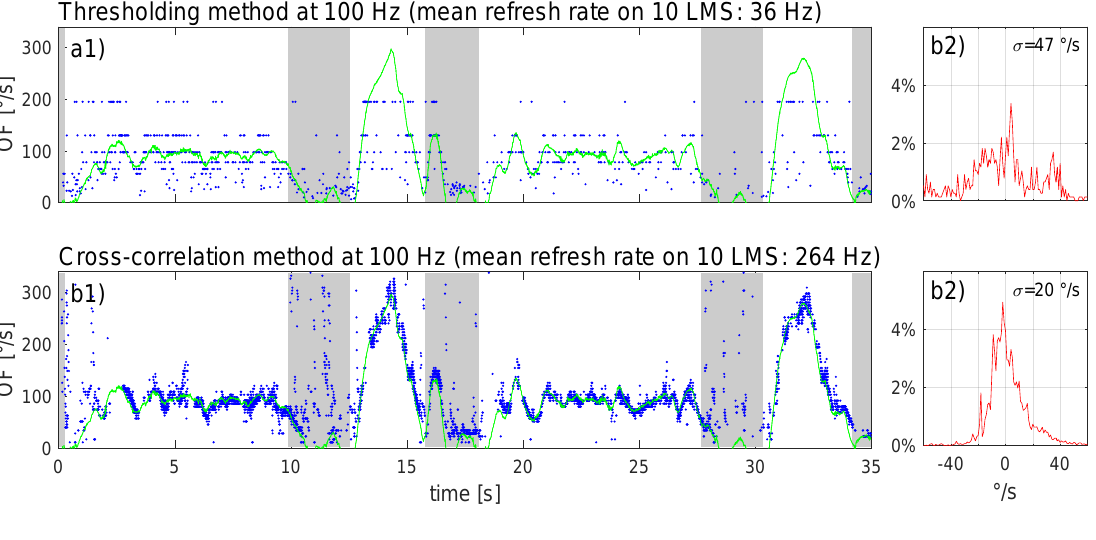
Figure 11. OF computed with ( a ) the thresholding method and ( b ) the cross-correlation method after down-sampling the data underlying Figure 9 to F e = 100Hz. Table 1. Comparison between the results obtained with the two time-of-travel